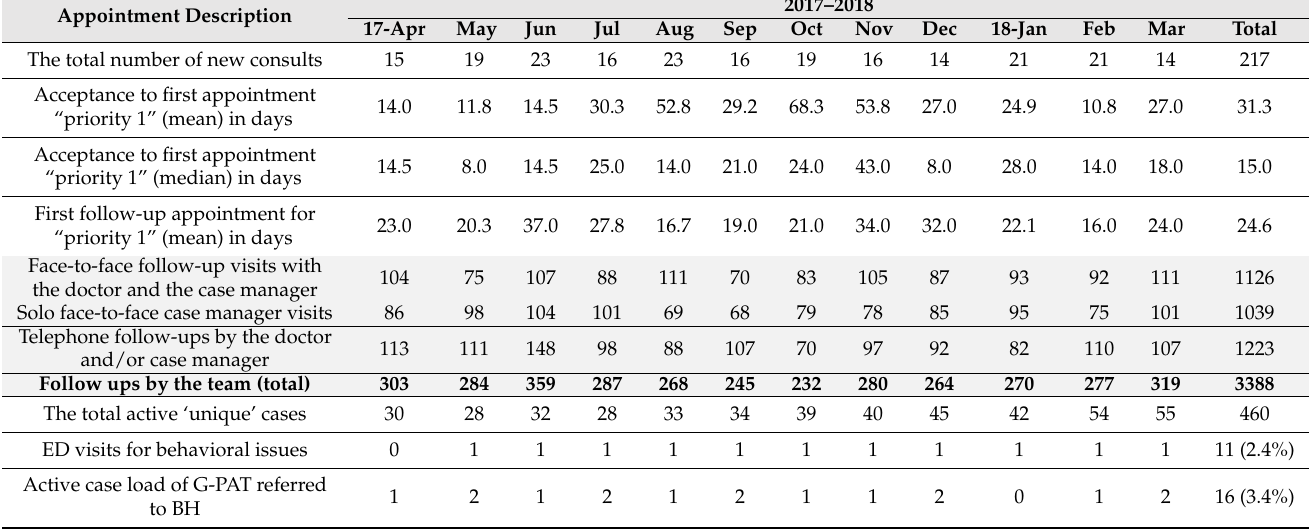
Table 1. The timelines for the initial assessment and first follow-up visits for